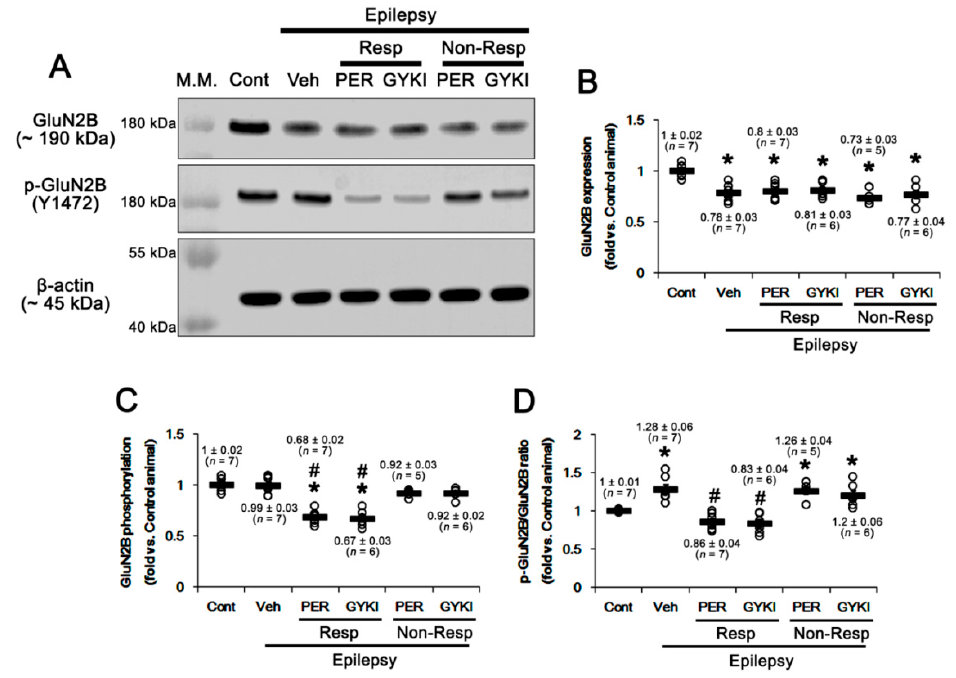
Figure 2. The effects of perampanel (PER) and GYKI 52,466 (GYKI) on total glutamate ionotropic receptor NMDA type subunit 2B (GluN2B) expression and its tyrosine (Y) 1472 phosphorylation (p-GluN2B) in chronic epilepsy rats. ( A ) Representative images for Western blot of GluN2B and GluN2B Y1472 levels in the hippocampal tissues. ( B – D ) Quantifications of GluN2B ( B ), p-GluN2B ( C ), and p-GluN2B/GluN2B ratio ( D ) in the hippocampal tissues. Open circles indicate each individual value. Horizontal bars indicate mean value. Error bars indicate SEM ( *, # p < 0.05 vs. control and vehicle (Veh)-treated animals, respectively; one-way ANOVA with post hoc Bonferroni’s multiple comparison).